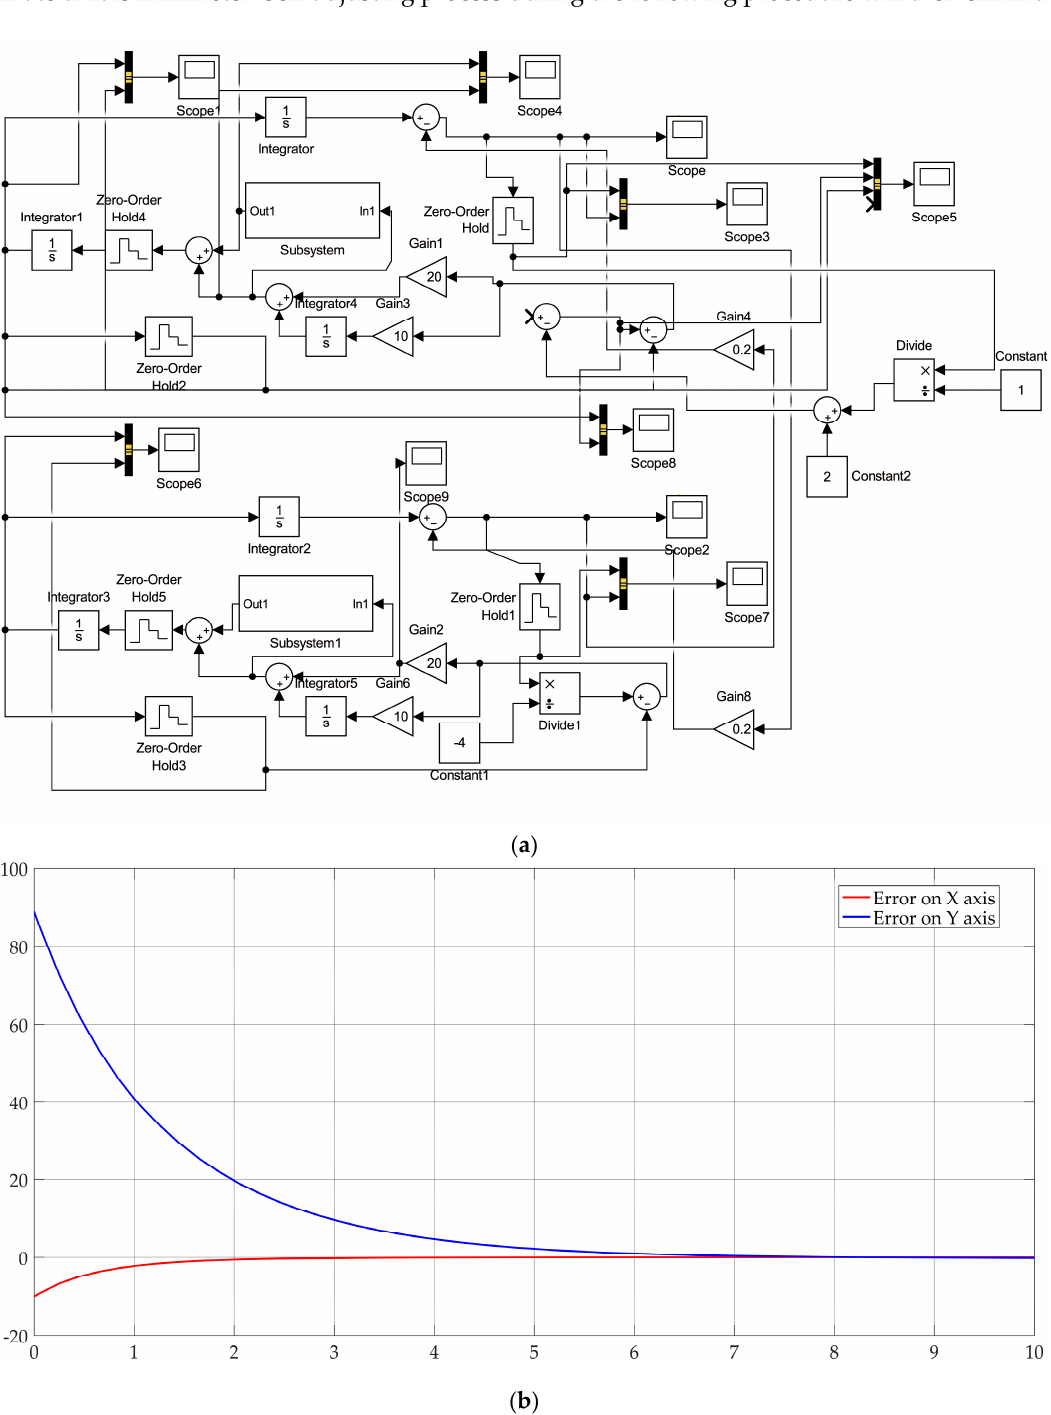
Figure 6. The simulation in Simulink and convergence of results for linear motion. ( a ) Simulink simulative model graph; ( b ) The model reaches a steady convergent state.